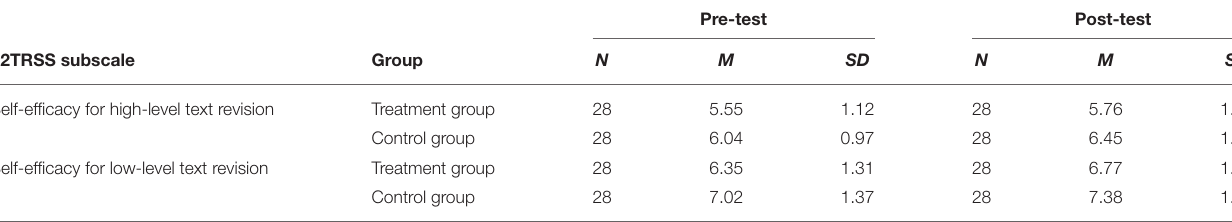
TABLE 2 | Descriptive information on L2TRSS scores for each group.